Question: What does this figure show? Answer in one sentence.
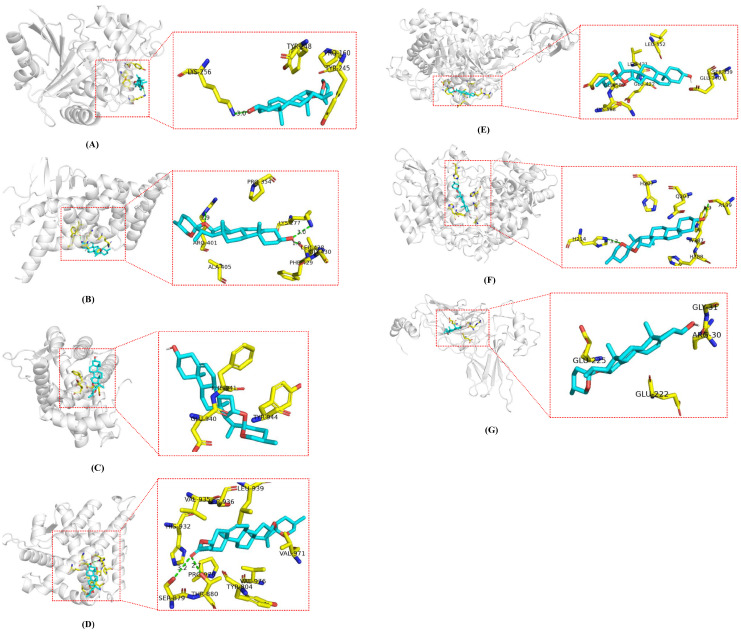
Answer: Molecular docking results (Bixie). (A) Molecular docking of CAT with diosgenim. (B) Molecular docking of NR1I2 with diosgenim. (C) Docking plot of NR3C2 with diosgenim. (D) Docking of NR3c2 with EINECS_213-897-0. (E) Docking of PLA2G4A with diosgenim. (F) Docking of PTGS2 with diosgenim. (G) Docking of RELA with diosgenim.